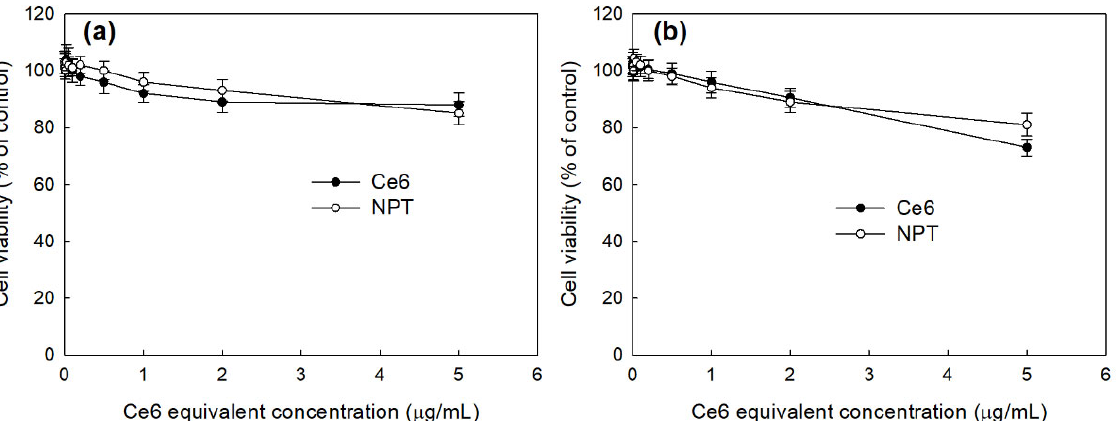
Figure 6. Dark toxicity of free Ce6 and nanophotosensitizers. ( a ) RAW264.7 cells; ( b ) HeLa cells. Cells were treated with free Ce6 or HAthCe6 nanophotosensitizers for 2 h without light irradiation. For control treatment, serum ‐ free media were used for comparison.